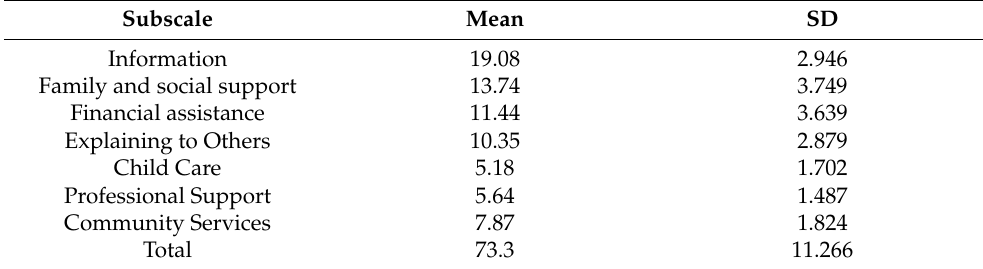
Table 2. Total and subscales scores of the Family Needs